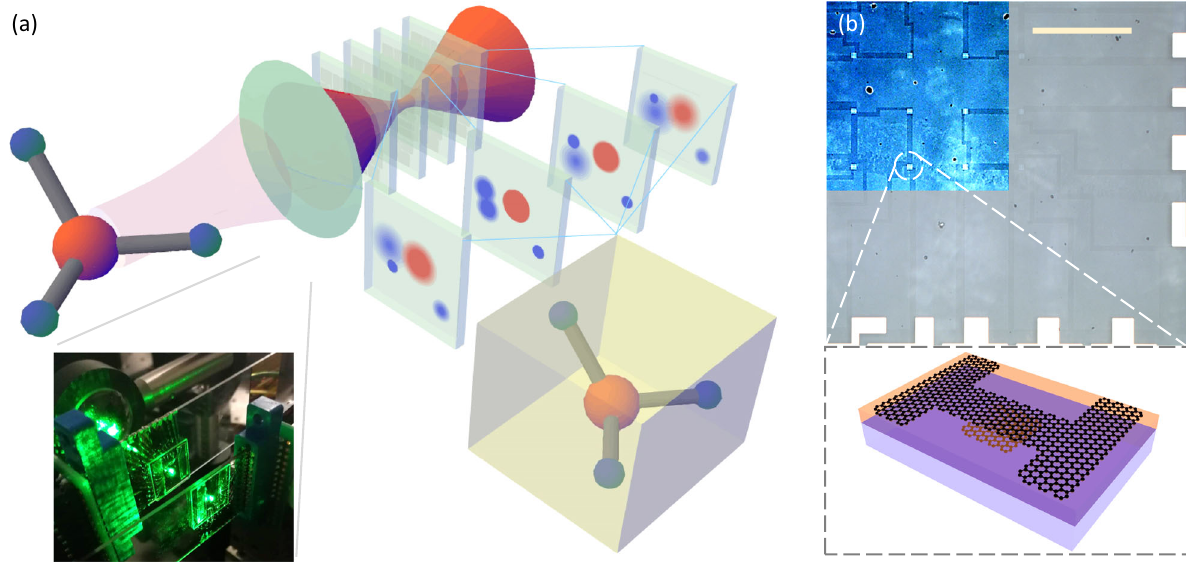
Fig. 1 Concept of focal stack imaging system enabled by focal stacks of transparent all-graphene photodetector arrays. a Schematic showing simultaneous capture of multiple images of a 3D object (ball-and-stick model) on different focal planes. Transparent detector arrays (transparent blue sheets) are placed after the lens (green oval) to form the camera system. The depth information is encoded in the image stacks. Arti fi cial neural networks process the image data and extract important 3D con fi guration information of the object. Inset: photograph of imaging system used in experiments with two transparent focal planes. b Upper panel: Optical image of a 4 × 4 transparent graphene photodetector array, scale bar: 500 μ m. Upper-left corner is with false color and enhanced contrast in order to highlight the patterns. Lower panel: Schematic of the all-graphene phototransistor design. It includes a top graphene layer as transistor channel and a bottom graphene patch as fl oating gate, separated by a 6-nm silicon tunneling barrier (purple). The device is fabricated on transparent glass substrate (blue), and the active detector region is wired out with wider graphene stripes as